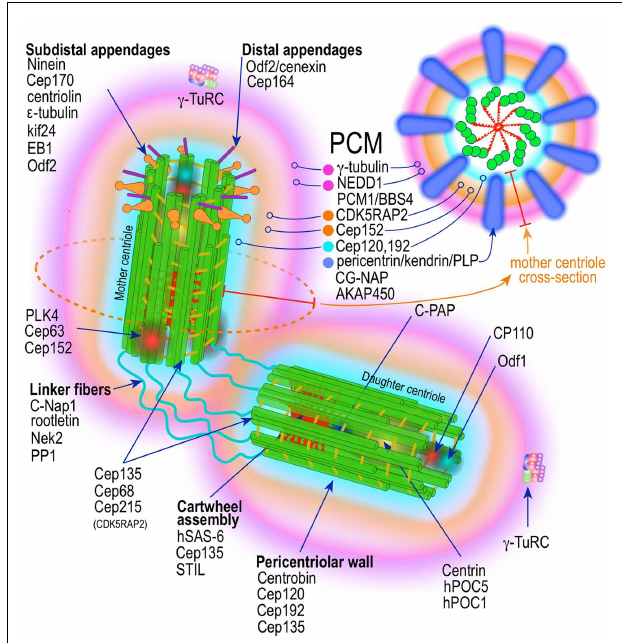
FIGURE 2 | Prototypic vertebrate centrosome . Salient architectural features of the post-mitotic centrosome (after centriole disengagement, but before procentriole nucleation) include fully developed mother and daughter centrioles and electron dense but highly structured pericentriolar material (PCM).